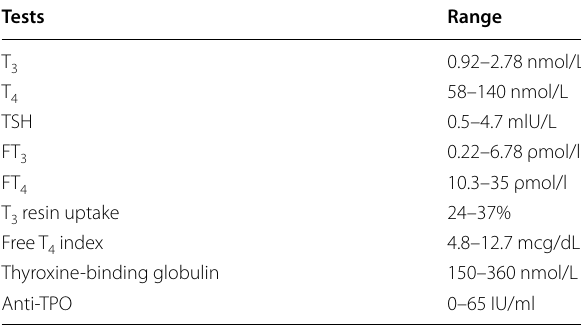
Table 2 Reference ranges of hormone profile